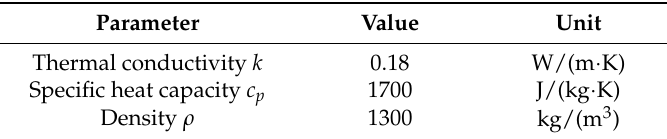
Table 1. Physical parameters of epoxy resin.